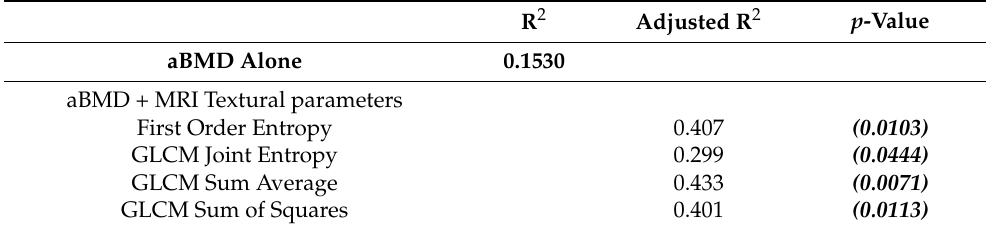
Table 6. Multiple regression analysis: combinations of aBMD and MRI textural parameters used to explain the femur failure stress (aBMD: areal bone mineral density; GLCM: grey level coocurrence matrix; GLRM: grey level run-length matrix). In bold and italic, p -value under 0.05. R